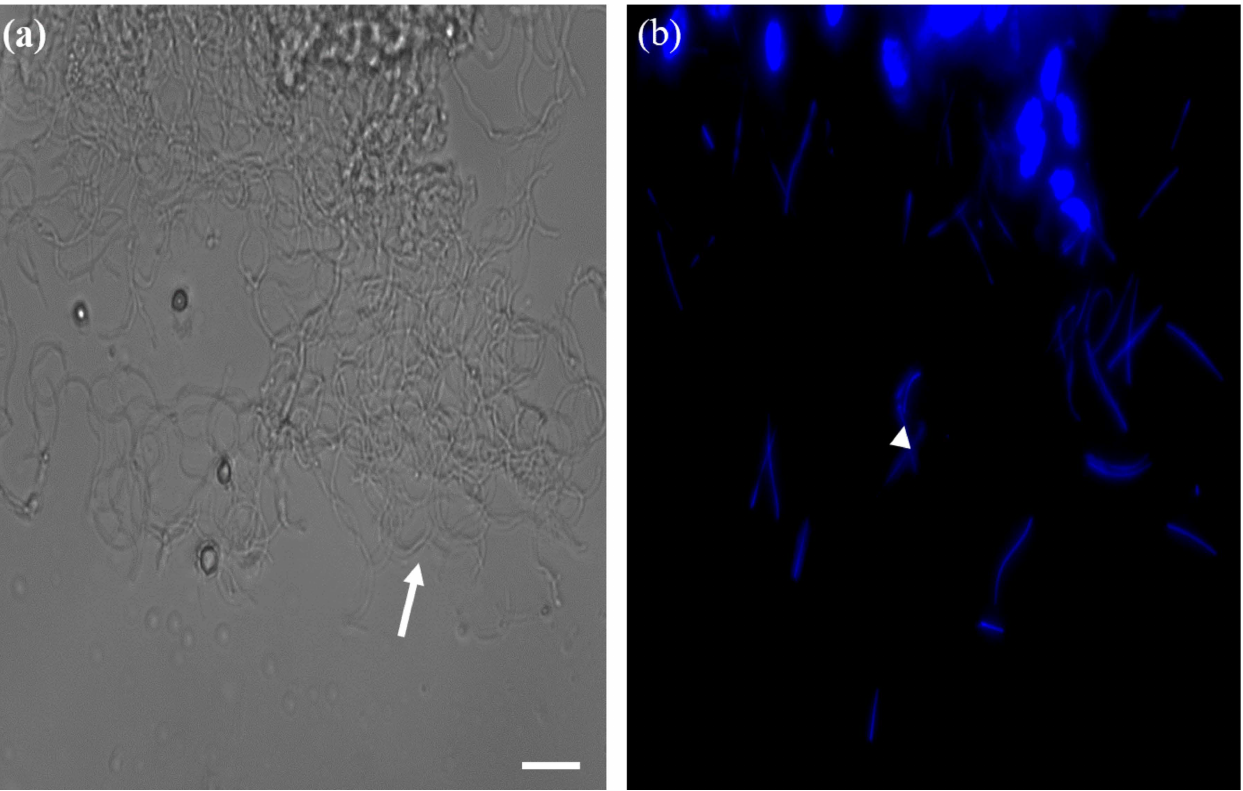
Figure 5. Histology of testis of male adult mealworm. ( a ) Sperms with long-tails (arrow) were observed in the testis and, ( b ) sperm nuclei (arrow-head) were stained with DAPI. Scale bars = 50 µ